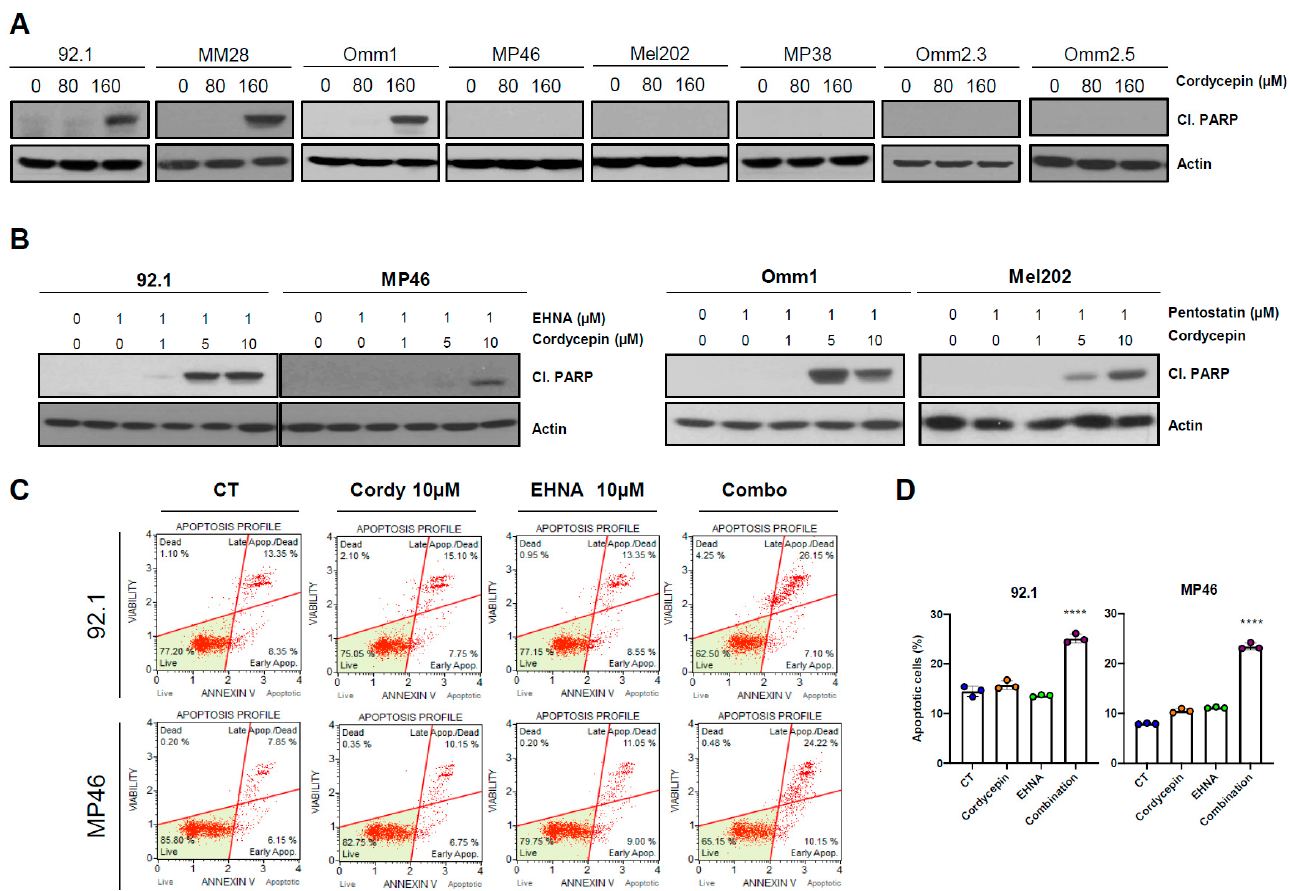
Figure 4. Apoptotic induction in uveal melanoma cells. ( A , B ) Uveal melanoma cells were treated with cordycepin only, or combination treatment with 3 ′ -deoxyadenosine and ADA inhibitors, and the expression cleaved poly-(ACP-ribose) polymerase (PARP) was analyzed by Western blot analysis. ( C , D ) Cells were treated with 10 µ M cordycepin and 1 µ M EHNA for 48 h, and the distribution of Annexin V positive cells was analyzed by flow cytometry. Values represent mean ± SD of experiments conducted in triplicate. **** p < 0.0001 by one-way ANOVA analysis of variance compared with the control group.